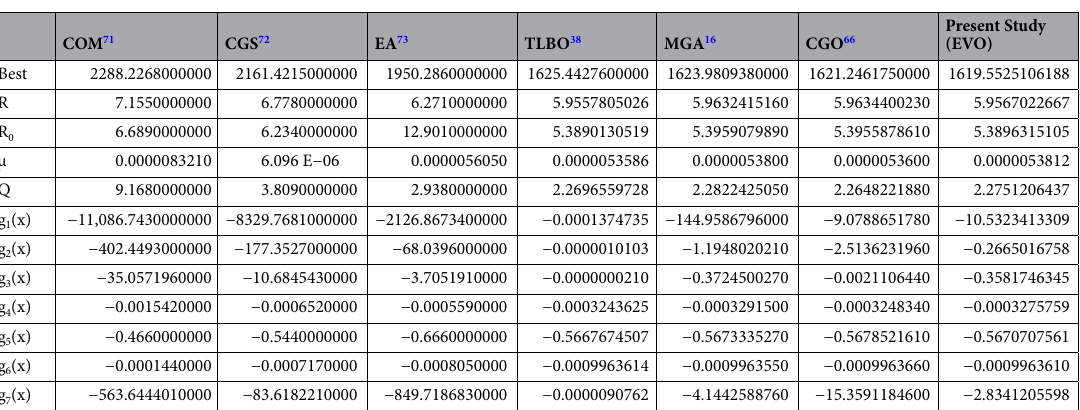
Table 10. Comparison of the best solutions for the hydro-static thrust bearing design problem. bearing step radius (R), recess radius (R0), oil viscosity (µ), flow rate (Q). COM Classic optimization method, CGS Combined genetic search, EA Evolutionary algorithm, TLBO Teaching–learning-based optimization.